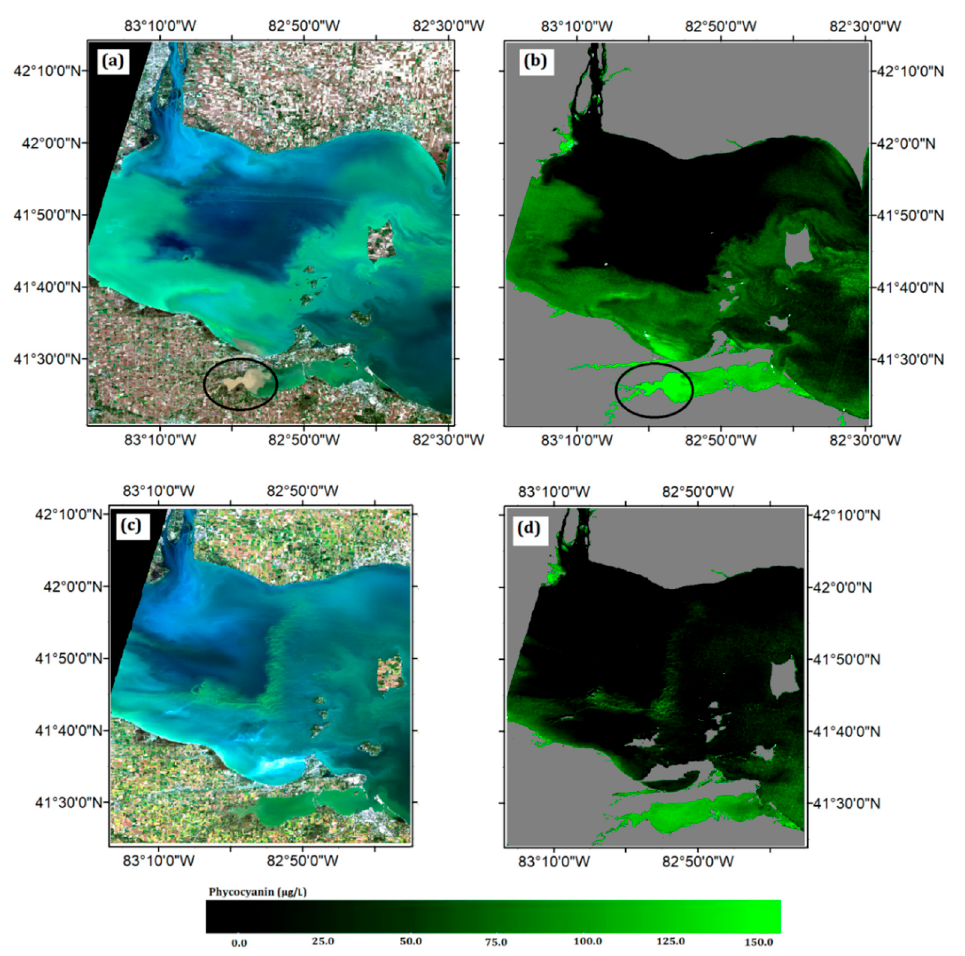
Figure 6. LS8-OLI-derived PC maps corresponding to a cyanobacteria bloom in Lake Erie on ( a , b ) 10 October 2013 and ( c , d ) 27 September 2014. The turbid region (marked with a circle) showed lower values of the orange band compared to the red band and consequently higher PC estimation.